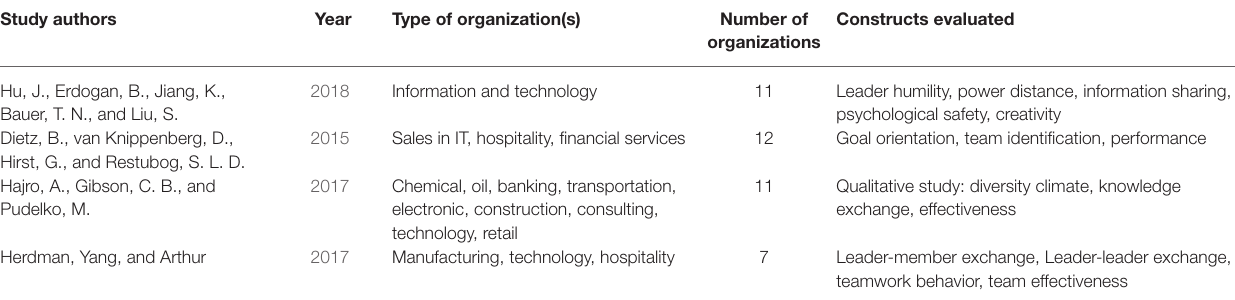
TABLE 1 | Summary of team research conducted in small organizations. Study